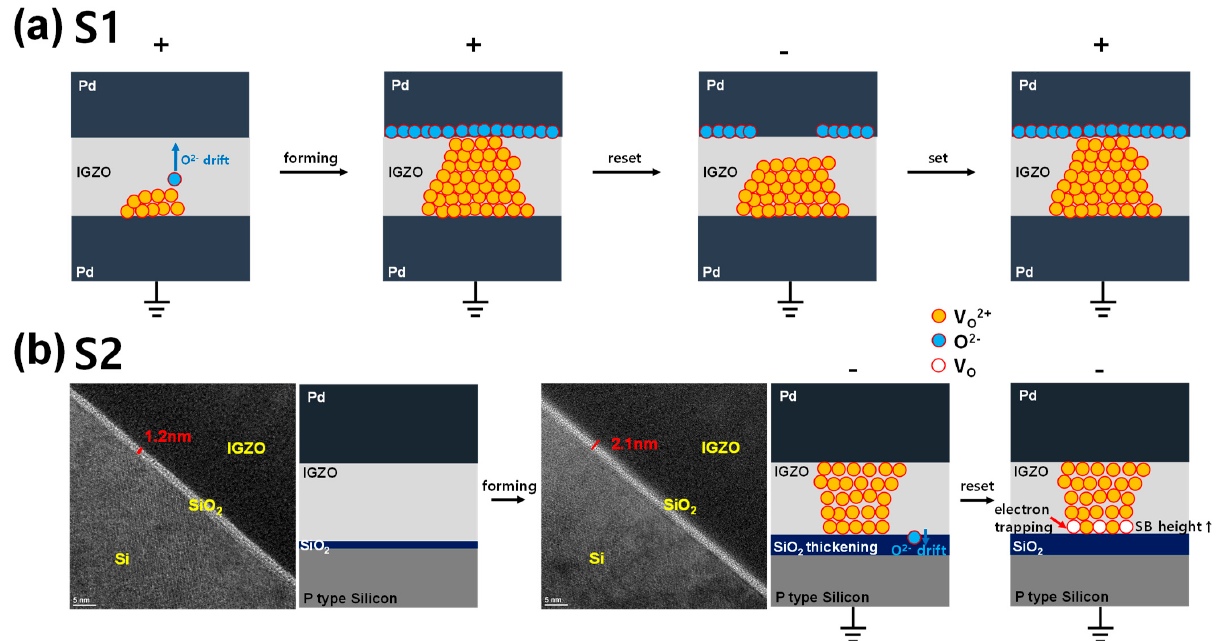
Figure 6. Schematic view of switching operations in ( a ) S1 and ( b ) S2. Lastly, the RTN signals of both devices were measured to analyze the electron trapping effects depending on the conduction mechanism. RTN is a type of intrinsic random noise, and it refers to a phenomenon in which device current randomly fluctuates by trapping or de-trapping of electrons [52,53]. In general, the RTN signals can be obtained when the CF is ruptured, and the device conduction is dominated by trap-assisted transport, but rarely occurs when the CF is formed since the CF can be hardly affected by electron trapping. The transient characteristics of the device current for the S1 and S2 were measured for 2 s (sample frequency = 10 kHz) under 0.1 V of the TE voltage, as shown in Figure 7a and b, respectively, which confirms that the RTN signals only occur in the HRS of the S1. This implies that the HRS of the S1 is conducted by trap-assisted transport, such as the Pool–Frenkel effect, which is in line with what has been discussed above. In contrast, the noise signals observed in the S2, regardless of the state, are believed to be thermal or 1/f noise rather than RTN signals [54] since its conduction mechanism is thermionic emission for both states, meaning that the S2 is hardly disturbed by intrinsic random noise during the read operation.